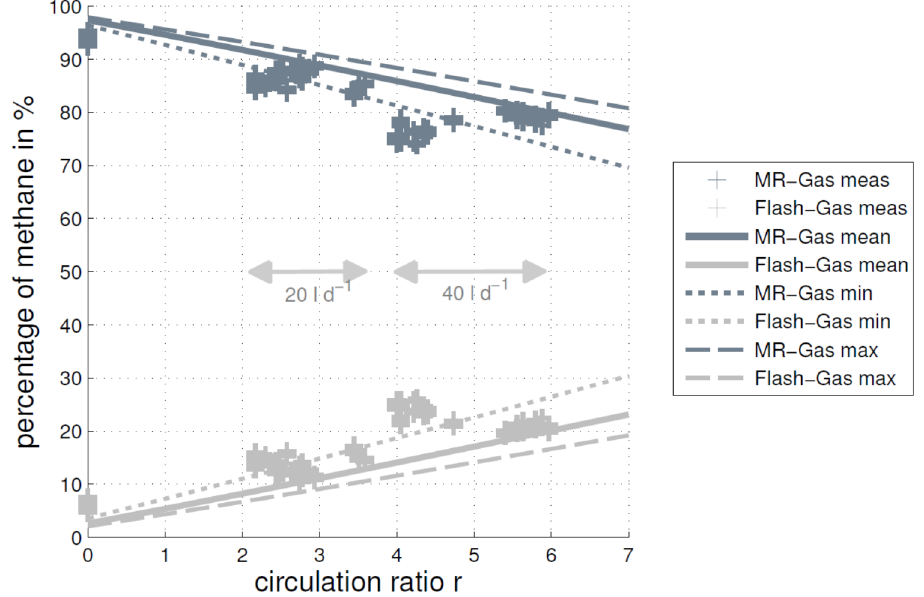
Figure 6. The distribution of methane between gas from the pressurized anaerobic filter n Φ MR,gas,out and gas from the decompression tank ( a ) “meas” refers to the experimental data; ( b ) “mean” refers to the calculation based on